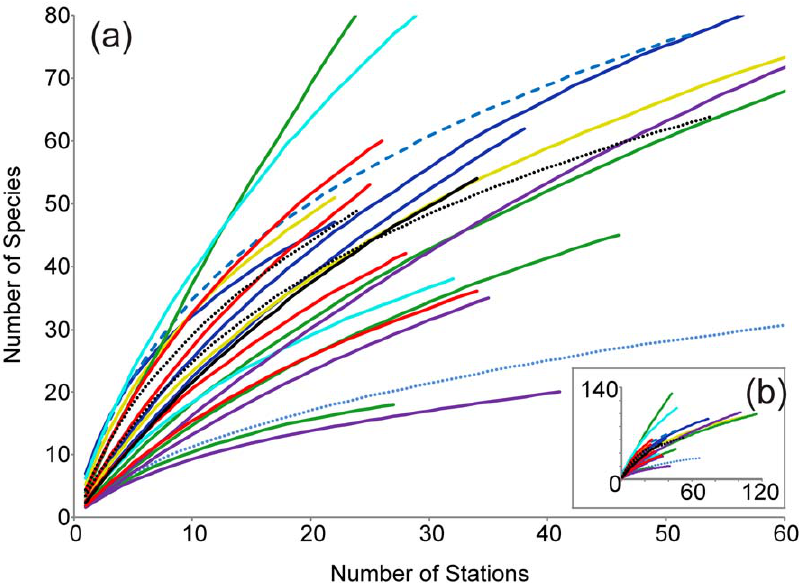
Figure 3. Rarefaction curves which show the accumulation of sponge species (all 3 classes of sponge were used) for selected 3 u by 3 u grid cells from the Southern Ocean and neighbouring regions. Rarefaction curves are coloured by region: Dark blue (solid)=Antarctic Peninsula; Blue (dashed)=East Weddell Sea; Blue (dotted)=East Antarctic; Turquoise (solid)=Ross Sea; Black (solid)=South Shetland Islands; Black (dotted)=South Georgia, Yellow (solid)=Kerguelen Islands; Red (solid)=South America and the Falkland Islands; Green (solid)=New Zealand (North Island); and Purple (solid)=South Africa.